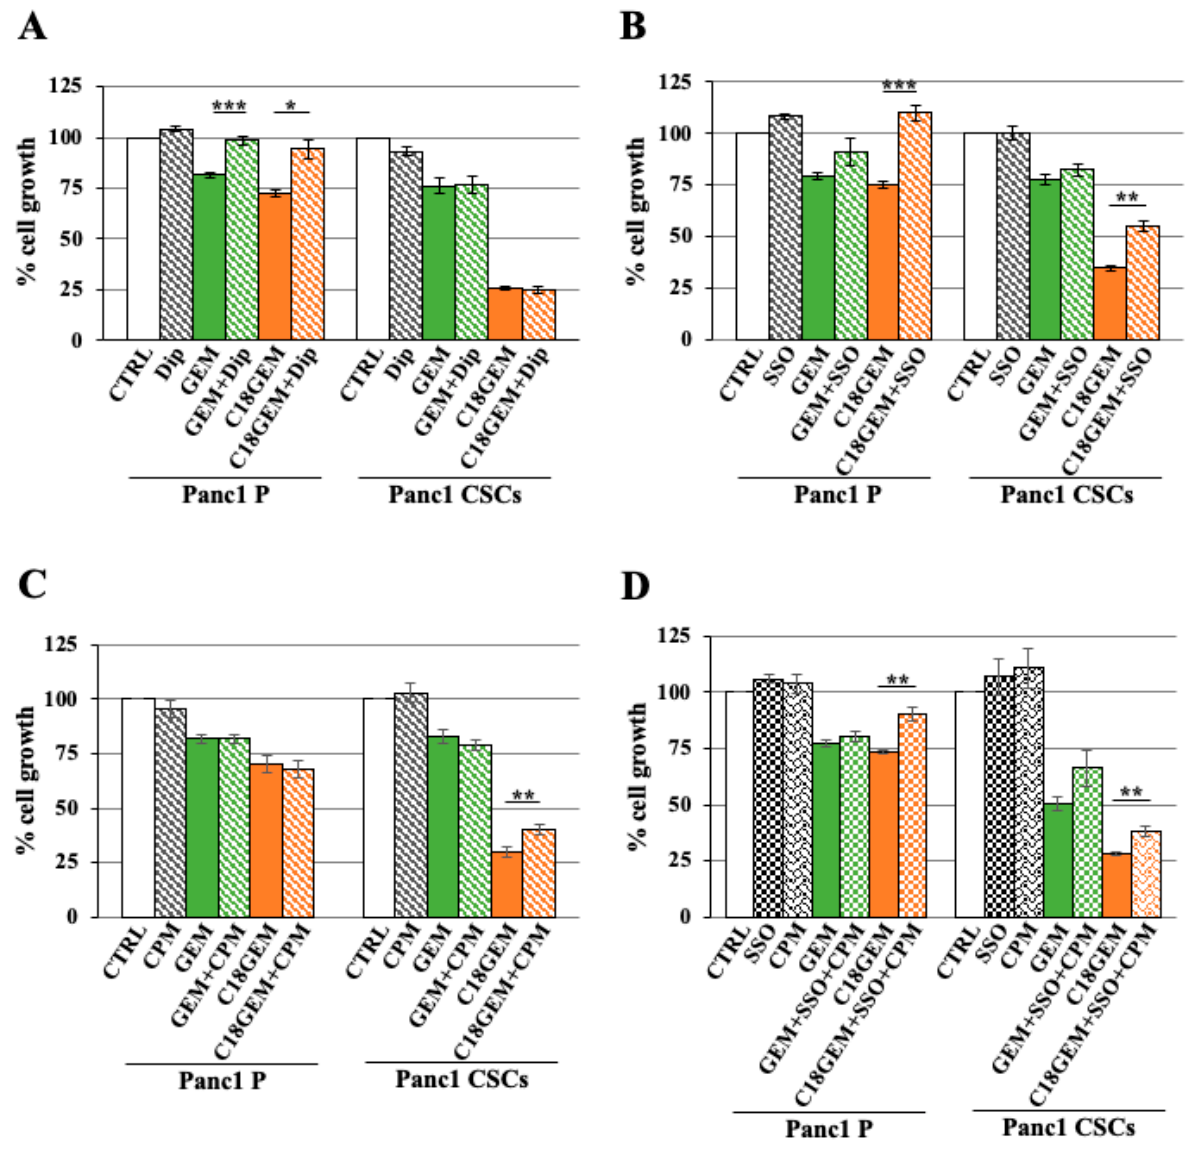
Figure 2. Intracellular uptake mechanisms of GEM and C18GEM in Panc1 parental and Panc1 CSCs. Cell viability analysis of Panc1 parental (P) cells and CSCs treated with 50 μ M of GEM or C18GEM for 72 h in 2D conditions in the absence or presence of 10 μ M dipyridamole (Dip) ( A ) or of 10 μ M sulfo-N-succinimidyl oleate (SSO) ( B ) or of 0.5 μ M chlorpromazine (CPM) ( C ) or a combination of SSO and CPM ( D ). Cell viability was measured by a Resazurin Cell Viability Assay Kit, as described in Materials and Methods. Values are the means (± SE) of at least three independent biological replicates. Statistical legend: p < 0.05 (*), p < 0.01 (**), or p < 0.001 (***), as indicated in figure.